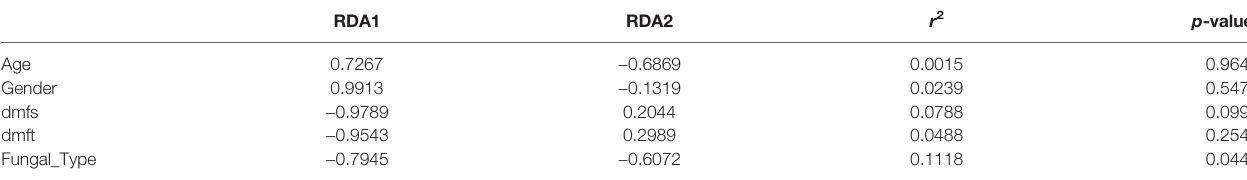
TABLE 3 | The calculations and p -values of redundancy